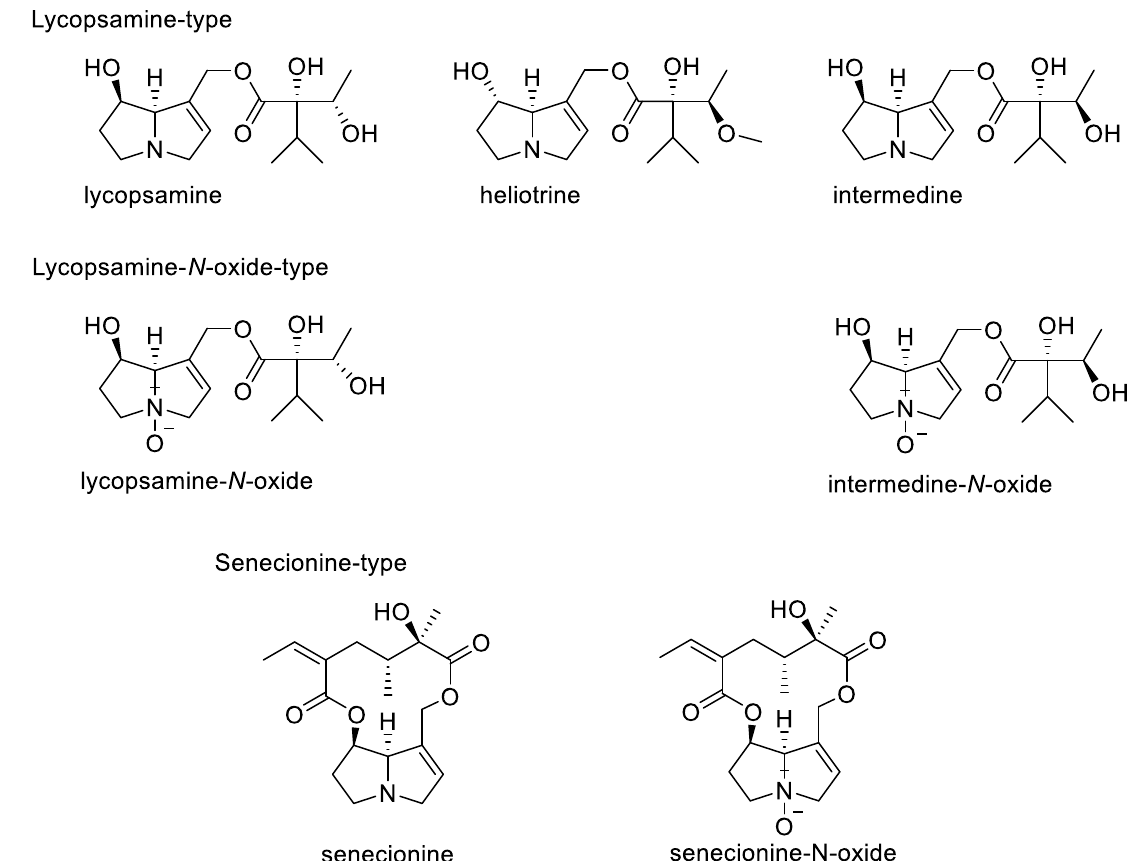
Figure 1. Exemplary chemical structures and features of some pyrrolizidine alkaloids (PAs).